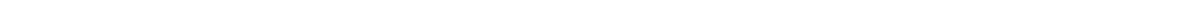
Fig. 3 Phasically activating VTA dopamine neurons reduces high alcohol drinking behaviors. a Timeline of experiments and schematic of surgeries in TH-BAC-Cre mice. High alcohol drinking TH-BAC-Cre mice expressing either AAV5-DIO-eYFP (eYFP, control vector) or AAV5-DIO-ChR2-eYFP (ChR2) were selected following the alcohol drinking paradigm to undergo bilateral optic ferrule implantation into the VTA followed by phasic optical stimulation. b Colocalization of AAV-DIO-ChR2-eYFP in TH + neurons of the VTA. n = 374 cells from 8 mice, scale bar = 150 μ m. c Electrophysiological validation of phasic light stimulation via ChR2 in VTA dopamine (DA) neurons eliciting action potentials (left) and (middle) inward currents in vitro and burst fi ring in vivo. d EtOH preference of high alcohol drinking mice following 15 min phasic stimulation of VTA DA neurons (two-way RM ANOVA: